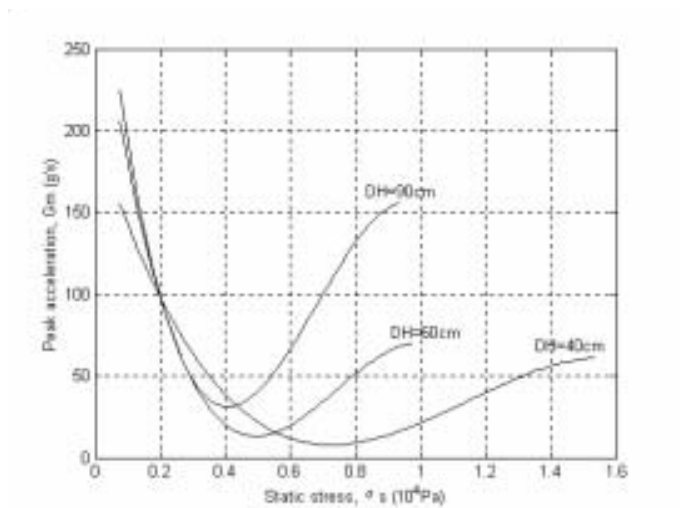
Fig. 7. Dynamic cushion curves of honeycomb paperboard ( T = 40